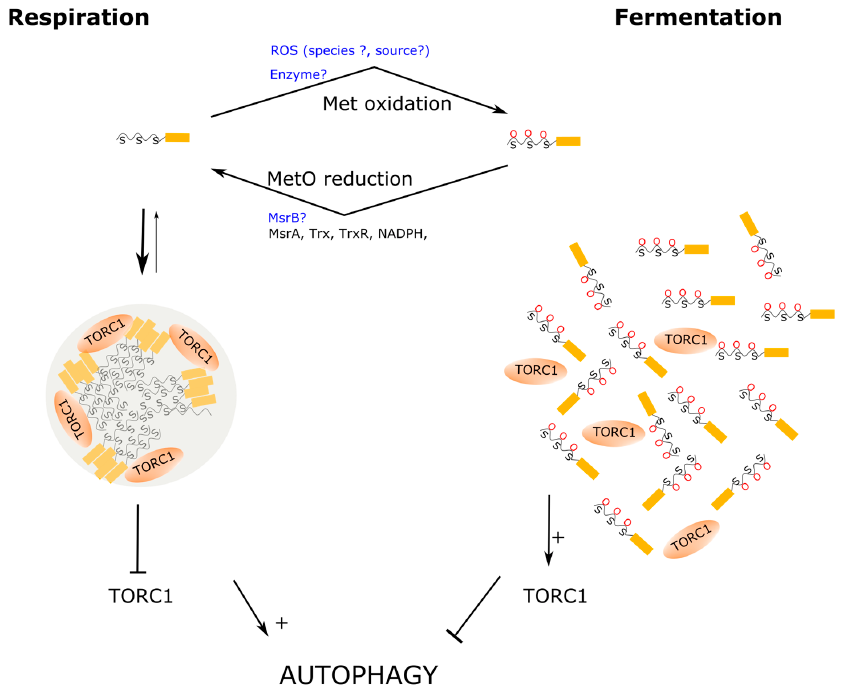
Figure 5. Metabolic status and autophagy level. The figure outlines the mechanism that coordinates the metabolic state (fermentation versus respiration) with the levels of autophagy (low and high, respectively). Key to this mechanism is the redox state of specific methionine residues of the Pbp1 protein. When these residues are in their reduced form, as methionines, the protein is competent to form biomolecular condensates that retain TORC1 in a non-soluble compartment. Since TORC1 has an inhibitory effect on autophagy, its sequestration within the condensates leads to the upregulation